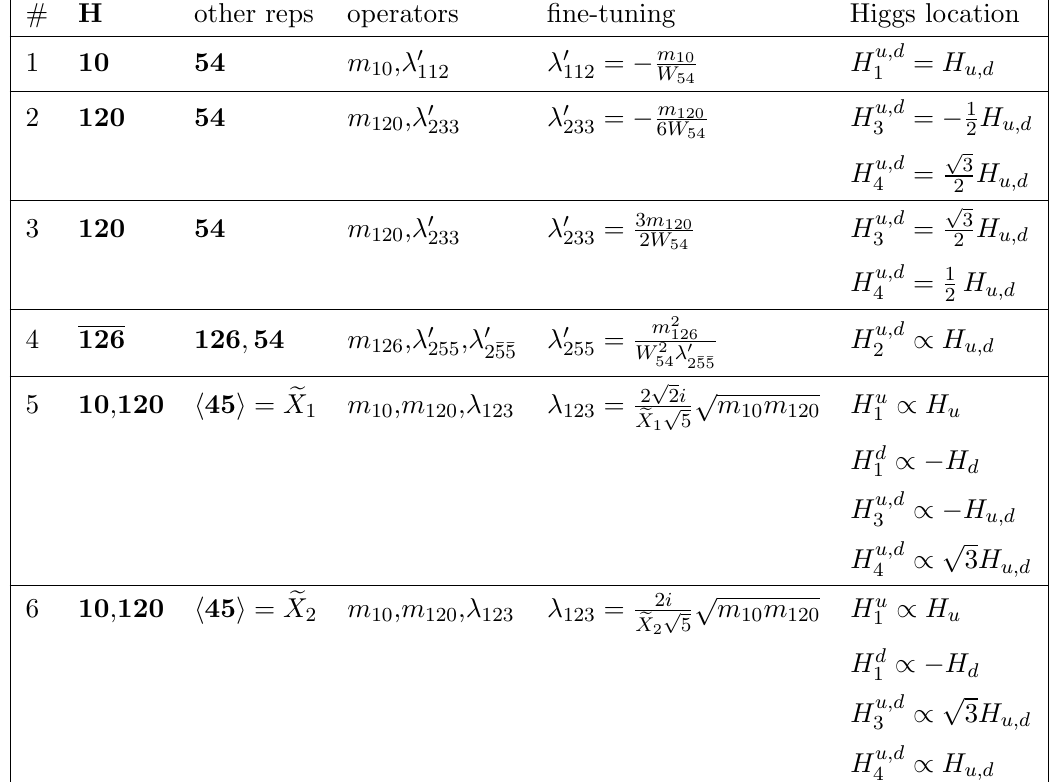
Table 7 . Examples of models of Higgs sectors with DT splitting giving predictive values with no free parameters for the (anti)doublet VEVs H u;d de(cid:12)ned in eq. (2.13) . For the predictions in the i Yukawa sector, one can replace / with =, see main body text for details. The scenarios are listed by their # number; we specify for each the available representations H , the other representations in the Higgs sector, the operators in the superpotential, the (cid:12)ne-tuning condition for DT splitting, and (cid:12)nally the location of MSSM Higgses H u;d in the (cid:13)avor states H u;d i